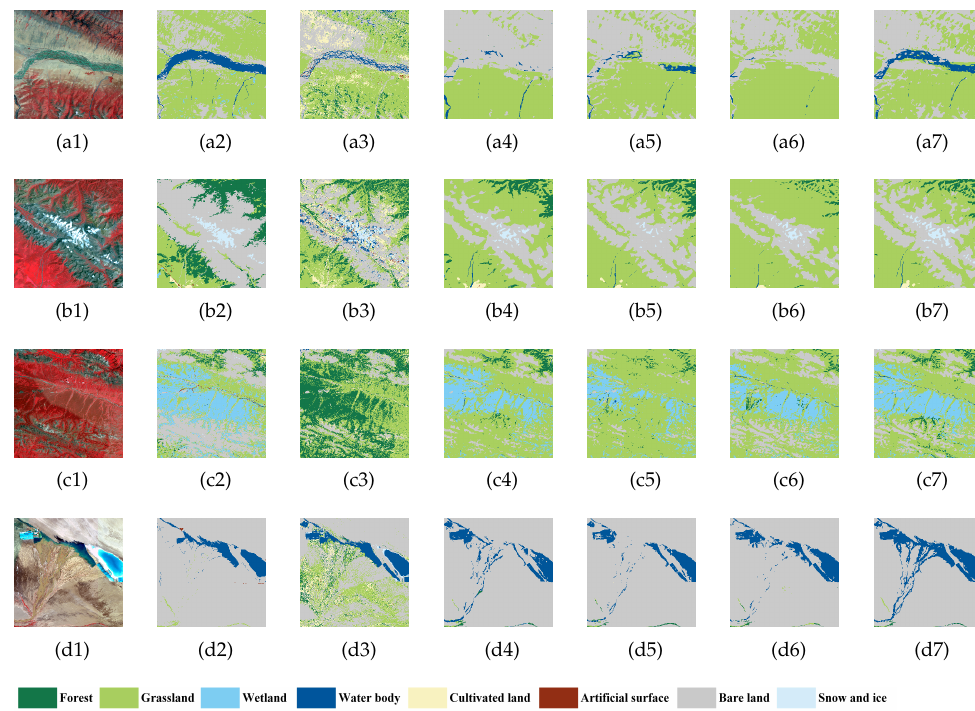
Figure 8. Detailed classification results for Qinghai, where ( a1 – d1 ) are the original Landsat images, ( a2 – d2 ) are the reference, ( a3 – d3 ) are classification results for RF classifier, ( a4 – d4 ) are classification results of PSPNet-RL, ( a5 – d5 ) are classification results of PSPNet, ( a6 – d6 ) are classification results of PSPNet-TF and ( a7 – d7 ) are classification results of MTNet. The results shown in ( a1 – b7 ) are for the year 2005; the results shown in ( c1 – d7 ) are for